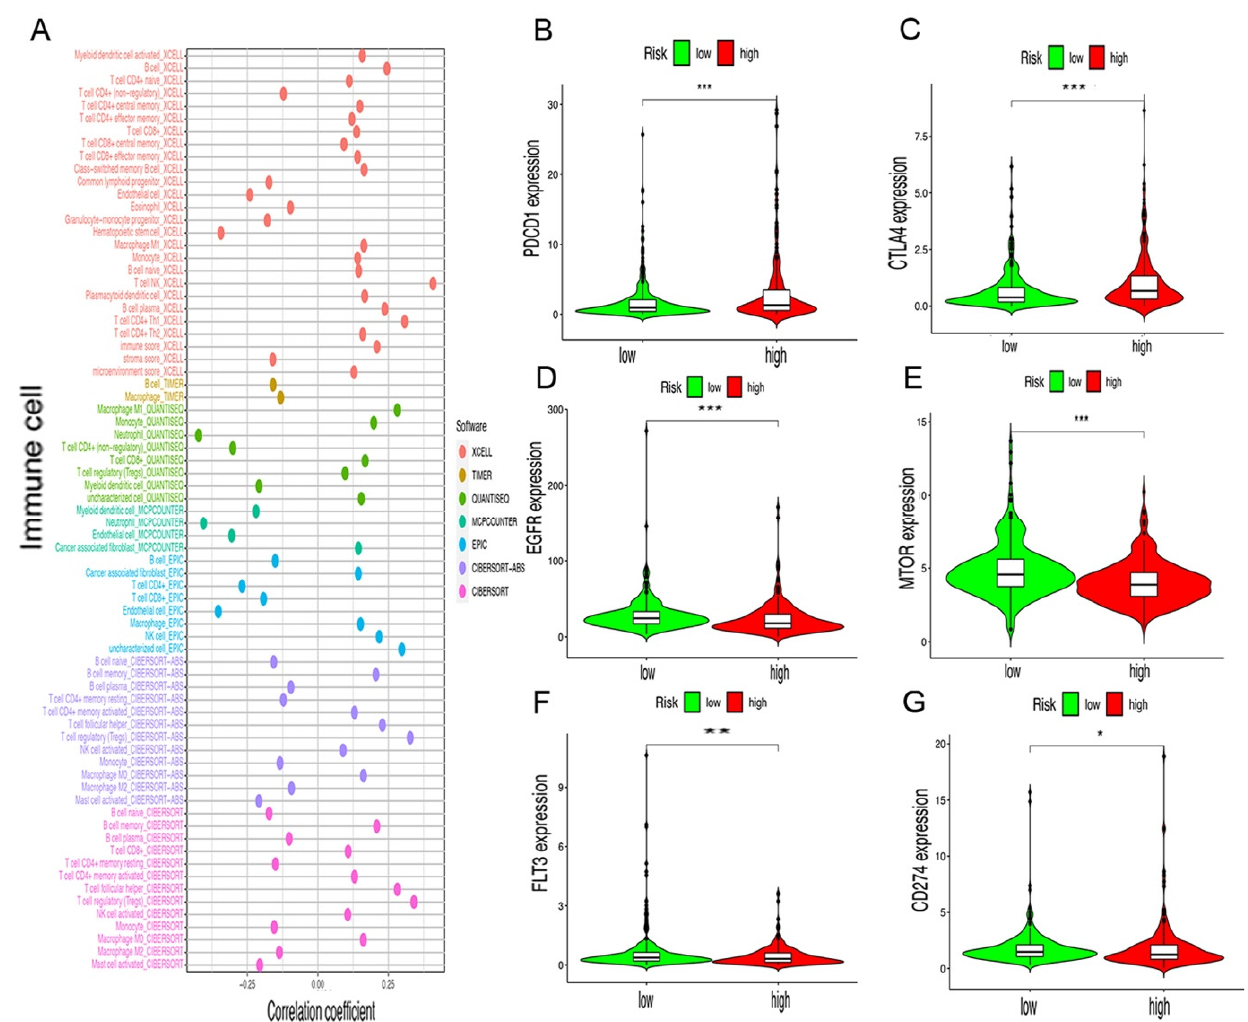
Figure 5. Evaluation of tumor immune cells and immunosuppressive molecules using the risk assessment model. ( A ) Spearman correlation analysis showed the correlation between patients in the high- or low-risk group and immune cells. ( B , C ) High risk scores were positively correlated with upregulated ( B ) PDCD1 and ( C ) CD274; ( D – F ) high risk scores were negatively correlated with low expression of ( D ) EGFR, ( E ) MTOR, ( F ) FLT3, and ( G ) CD274 levels in patients with KIRC. * p < 0.05; ** p < 0.01; *** p < 0.001.